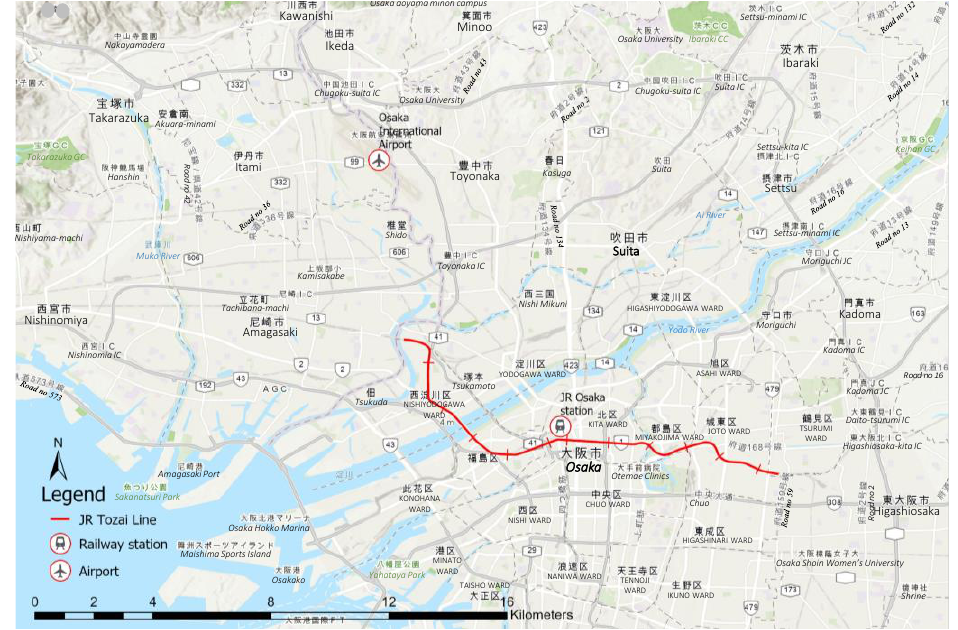
Figure 11. MLS survey site JR Tozai railway line, Osaka city, Japan (Railway line A).